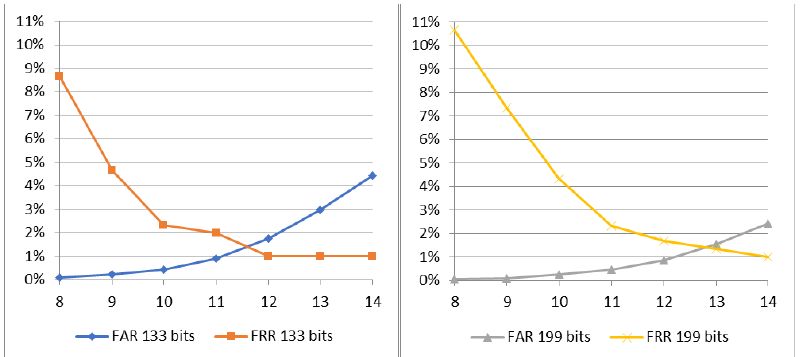
Figure 4. False acceptance rate (FAR) and false rejection rate (FRR) depending on absolute limit value T 1 and T 3 .